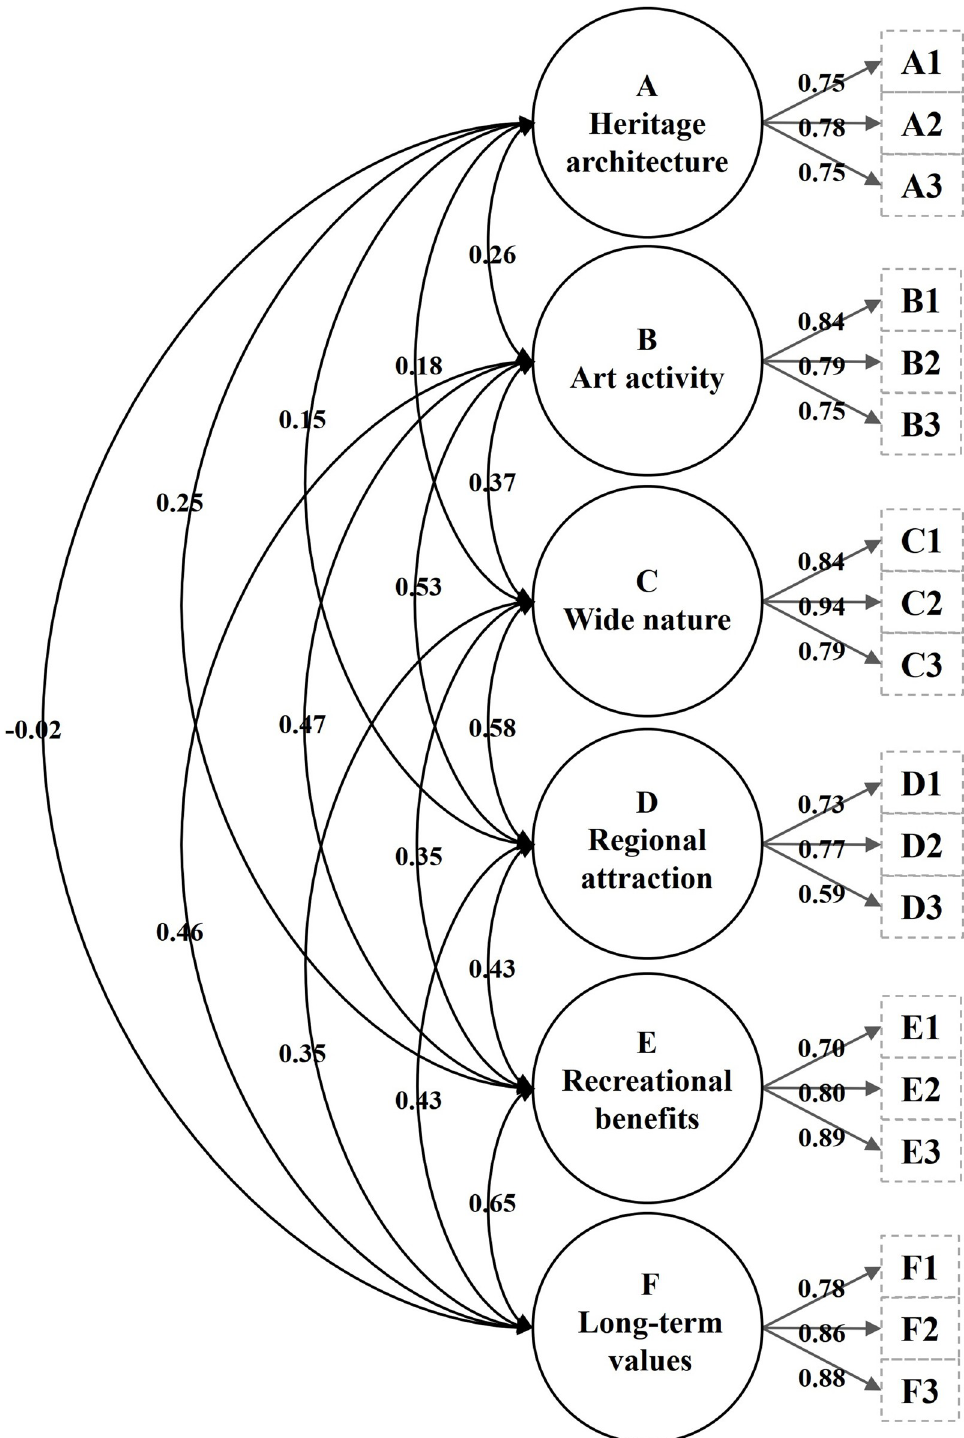
Fig 1. Initial first-order six-factor model of heritage tourism motivation.